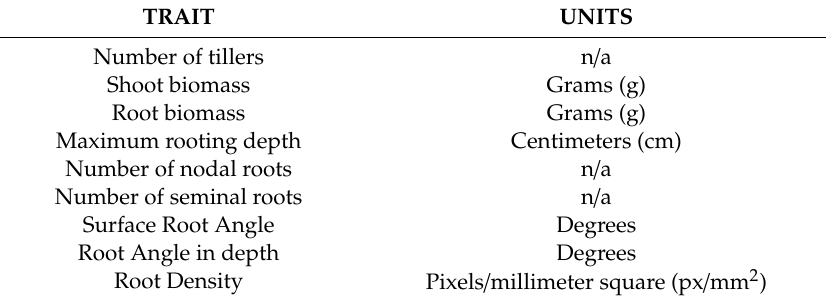
Figure 1. Root system of a two-month-old wheat plant excavated from the field. The location of the embryo after seed germination is marked with a magenta circle. The green arrow indicates the location of a seminal root, the root type that emerges from embryonic tissue during germination. The red arrow points to a post-embryonic root, which originates from coleoptile tissue. The white arrow marks a post-embryonic root that originates from the base of the leaf node. Table 1. Shoot and root traits quantified in Duster and Cheyenne. The first column lists the specific shoot and root traits quantified in the experiment. The second column shows corresponding units for each trait, when applicable. See Section 4 for a detailed explanation on methods for trait